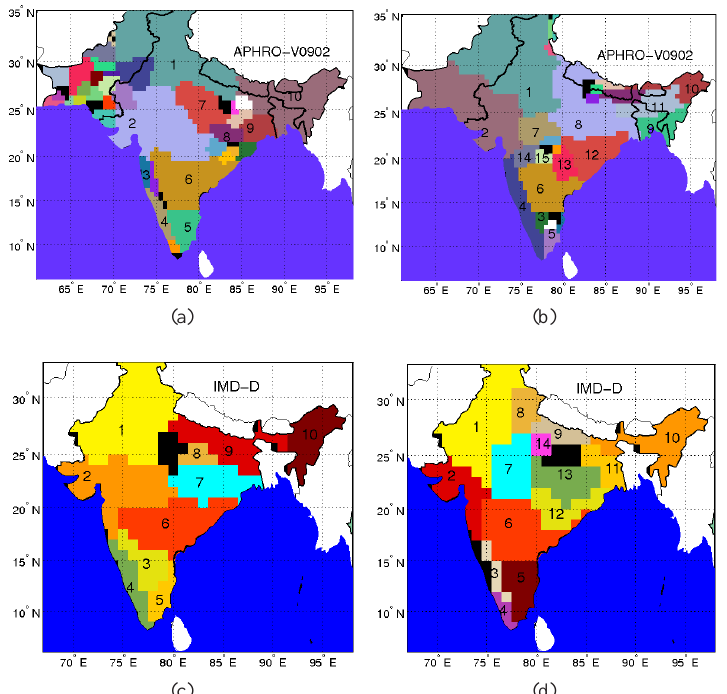
Fig. 6. Different colours here gives the different clusters obtained using Hierarchal clustering algorithm using matrix for Q as dissimilarity matrix. (a) Data used is APHRO-V0902, threshold α =94%, (b) data used is APHRO-V0902, threshold α =90%, (c) data used is IMD-D, threshold α =94%, (d) data used is IMD-D, threshold α = 90% , Data Used I l Fig no. Total Clusters Clusters containing greater than 3 grid points